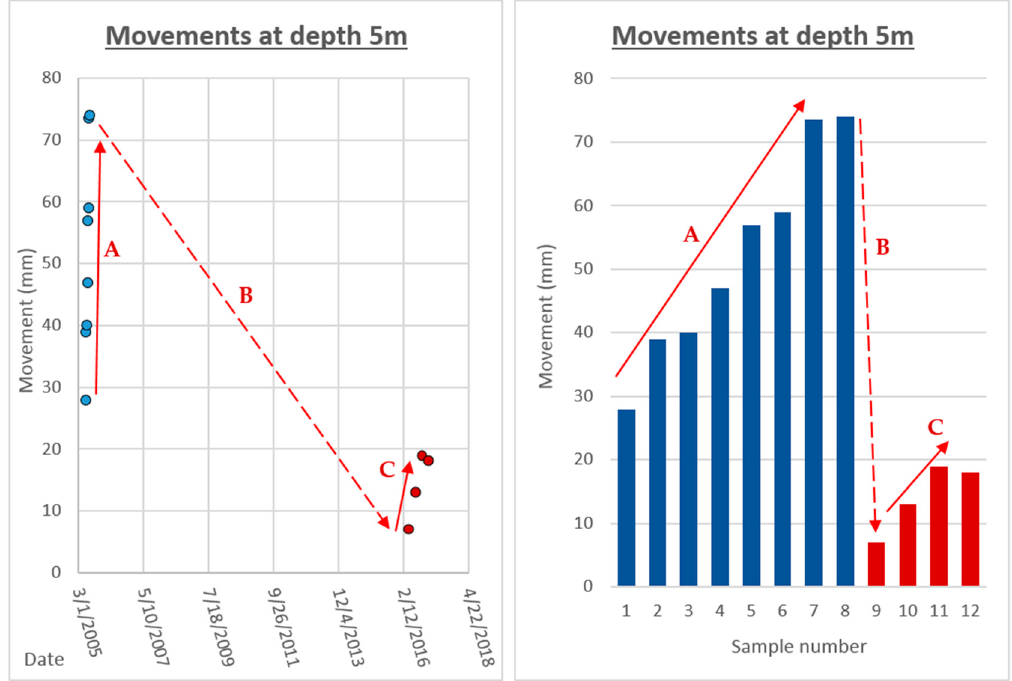
Figure 12. Evolution of the movements at a depth of 5 m. Long-term trend. The movements are represented in blue for borehole B5 (installed in year 2005) and brown for borehole B9 (installed in year 2016), Date given in Day/Month/Year. Letter A refers to the fast increment in deformations in 2005; B refers to the reduction of deformations between 2005 and 2016; C refers to the acceleration of deformations registered in 2016.